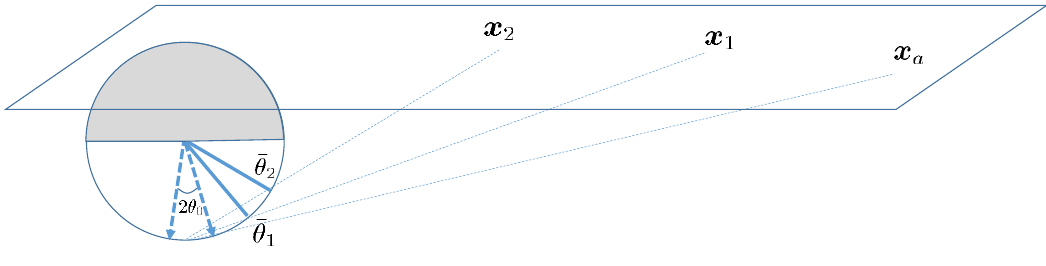
Figure 9 . The stereographic projection for the case where the di-jets are boosted along the negative z axis. Two successive soft gluon emissions, which make increasing angles (cid:18) 0 (cid:28) (cid:22) (cid:18) 1 (cid:28) (cid:22) (cid:18) 2 w.r.t. the negative z axis, are projected onto points with decreasing transverse coordinates, j x 2 j (cid:28) j x 1 j (cid:28) j x a (cid:0) x b j . The projection relates the anti-collinear time-like evolution to the collinear space-like